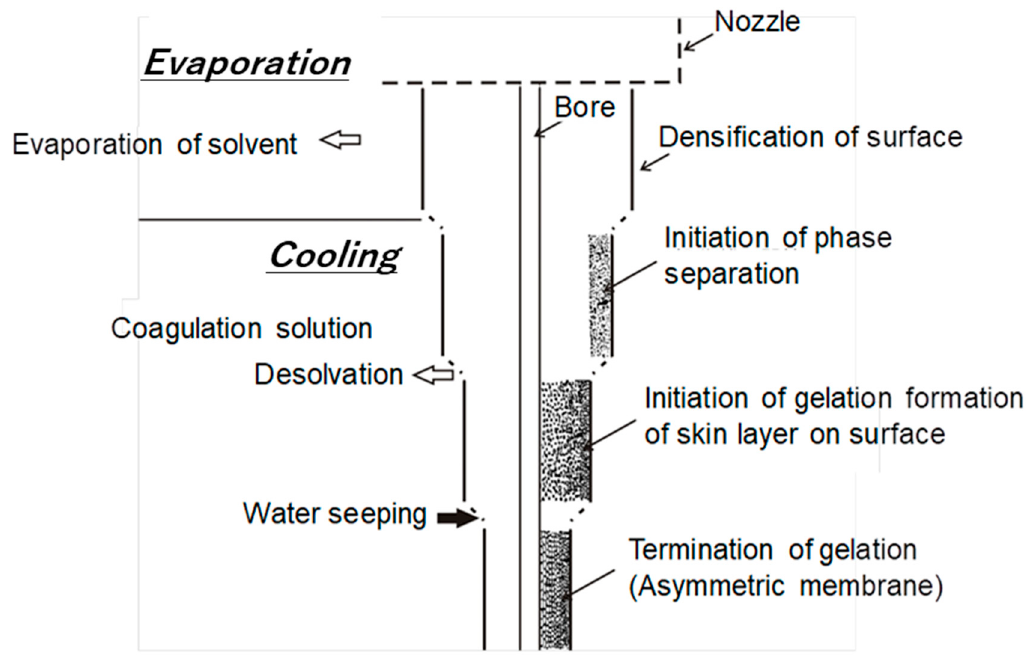
Figure 1. Typical diagram for preparation of an asymmetric membrane.